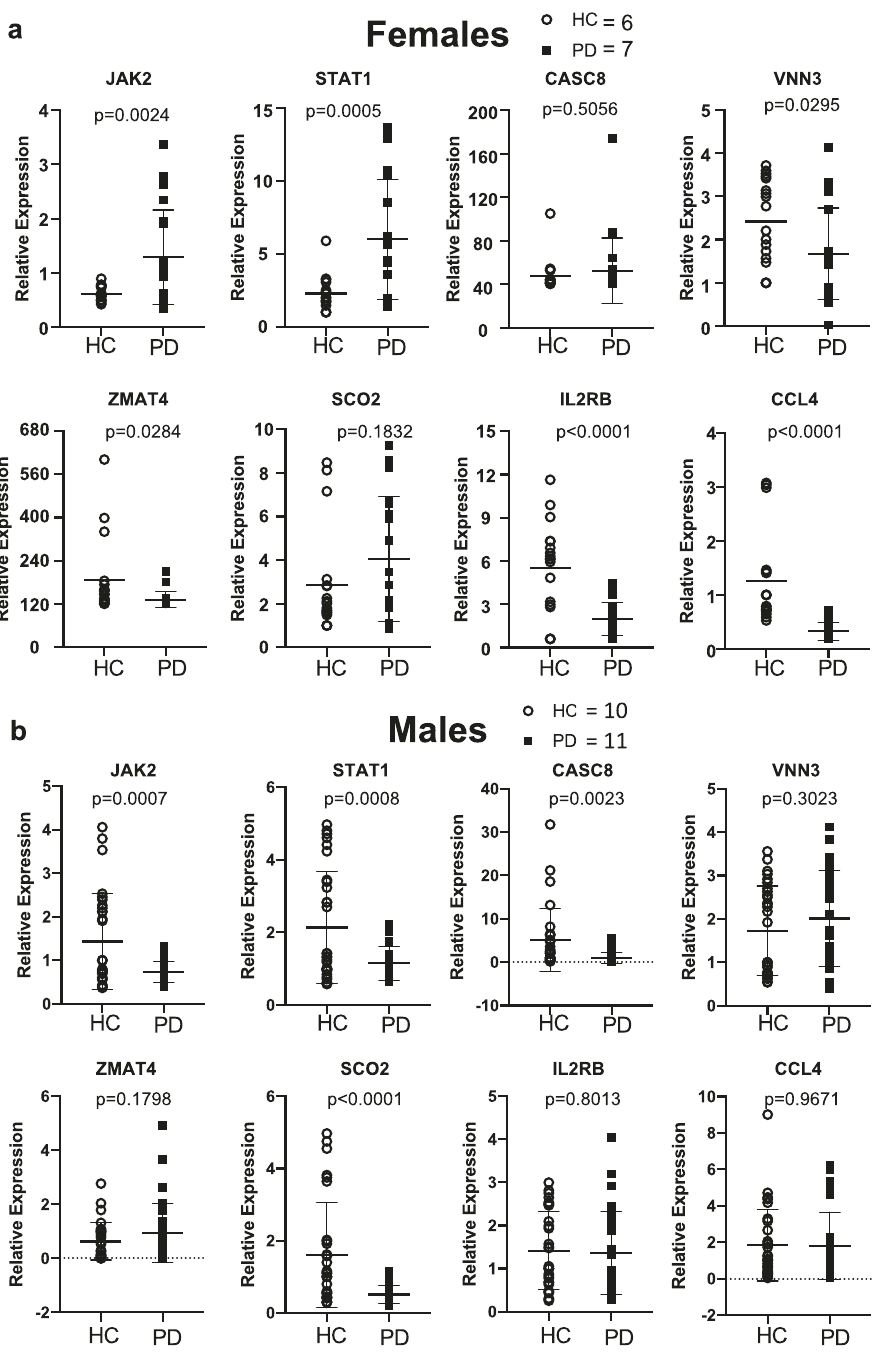
Fig. 5 mRNA expression in monocytes determined by qRT-PCR in HC and PD patients. RNA was extracted from isolated monocytes and qRT-PCR performed using primers for JAK2 , STAT1 , CASC8 , VNN3 , ZMAT4 , SCO2 , IL2RB , CCL4 with three repeated experiments in ( a ) females; HC = 6 and PD = 7 and ( b ) males; HC = 10 and PD = 11. Statistical signi fi cance was assessed with Student ’ s t-tests. Relative gene expression is shown as mean ± SD and all individual replicates are